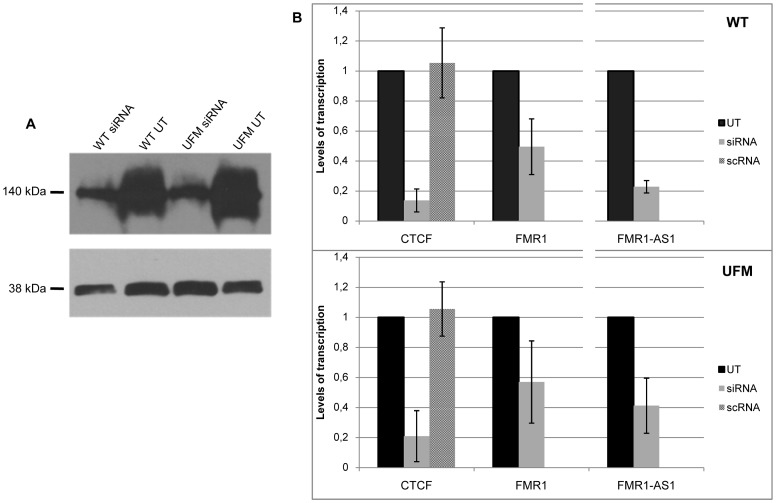

CTCF knock-down in WT and UFM fibroblasts.(A) Western blotting analysis of CTCF, visualized with ECL kit. Protein extracts from untreated (UT) and siRNA-treated WT and UFM fibroblasts were probed with an anti-CTCF rabbit polyclonal antibody (top panel) and one against GAPDH (bottom panel). After CTCF depletion a major reduction of the corresponding protein is visible. (B) Relative quantification through RT-PCR of CTCF and FMR1 sense and antisense transcripts in those knock-down experiments in which CTCF depletion is followed by FMR1 transcript reduction both in WT (upper panel) and UFM (bottom panel) fibroblasts. FMR1 sense transcript is reduced to around 50% in both cell lines with a consistent (about 80%) reduction of CTCF mRNA levels. Depletion of FMR1-AS1 (80 and 60% in WT and UFM cells, respectively) is also observed and directly correlates with CTCF reduction in both cell lines. The two cell lines were also transfected with a scramble siRNA (scRNA) without any modifications of CTCF transcript levels. Histograms represent mean and standard deviation of 10 independent knock-down experiments for UFM and WT.